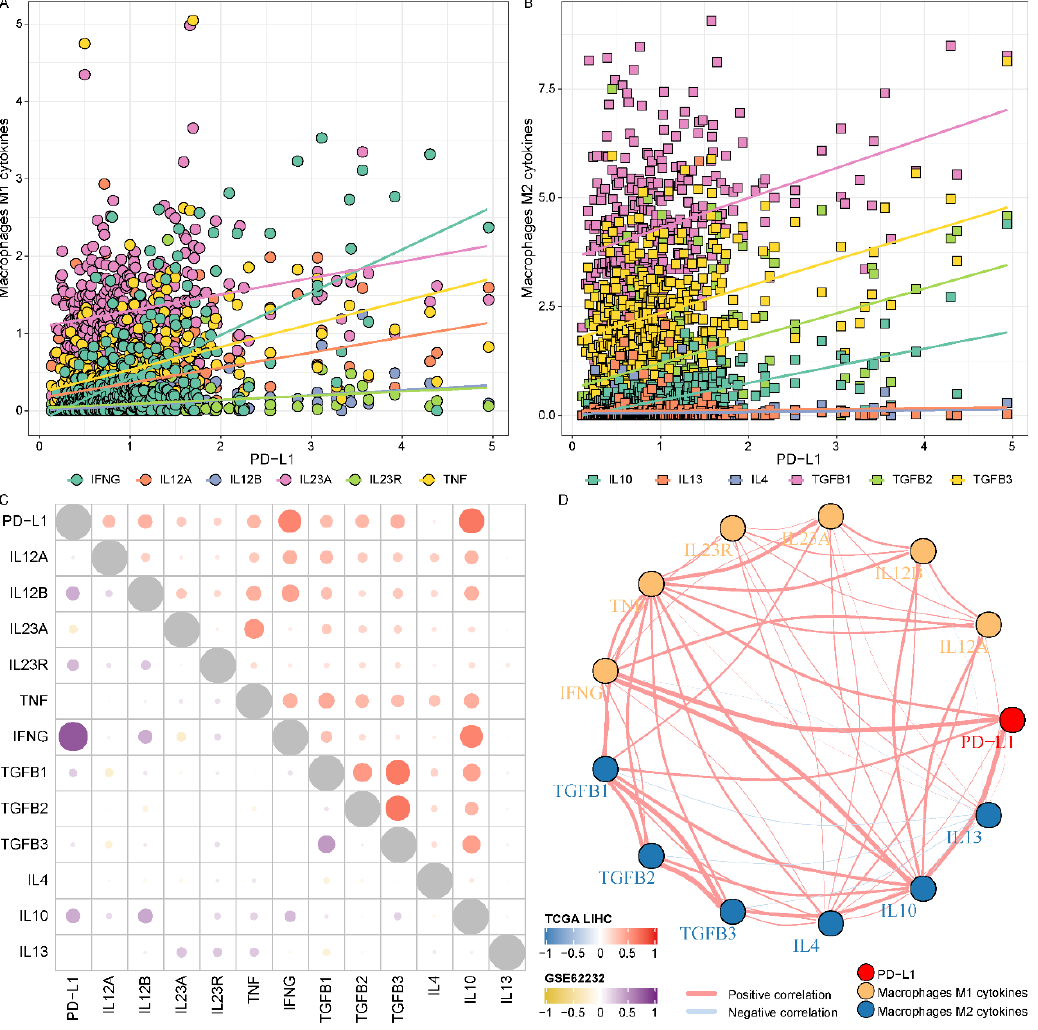
Figure 4. Association of the expression level of PD-L1 and macrophage-derived cytokines in HCC. ( A , B ) The relevance of the expression level of PD-L1 and macrophages (M1 and M2) related cytokines, respectively. ( C ) The correlation of PD-L1, macrophages M1 and M2 cytokines in the TCGA LIHC and GSE62232 validation cohorts. ( D ) The protein-protein interaction network of PD-L1 and cytokines.